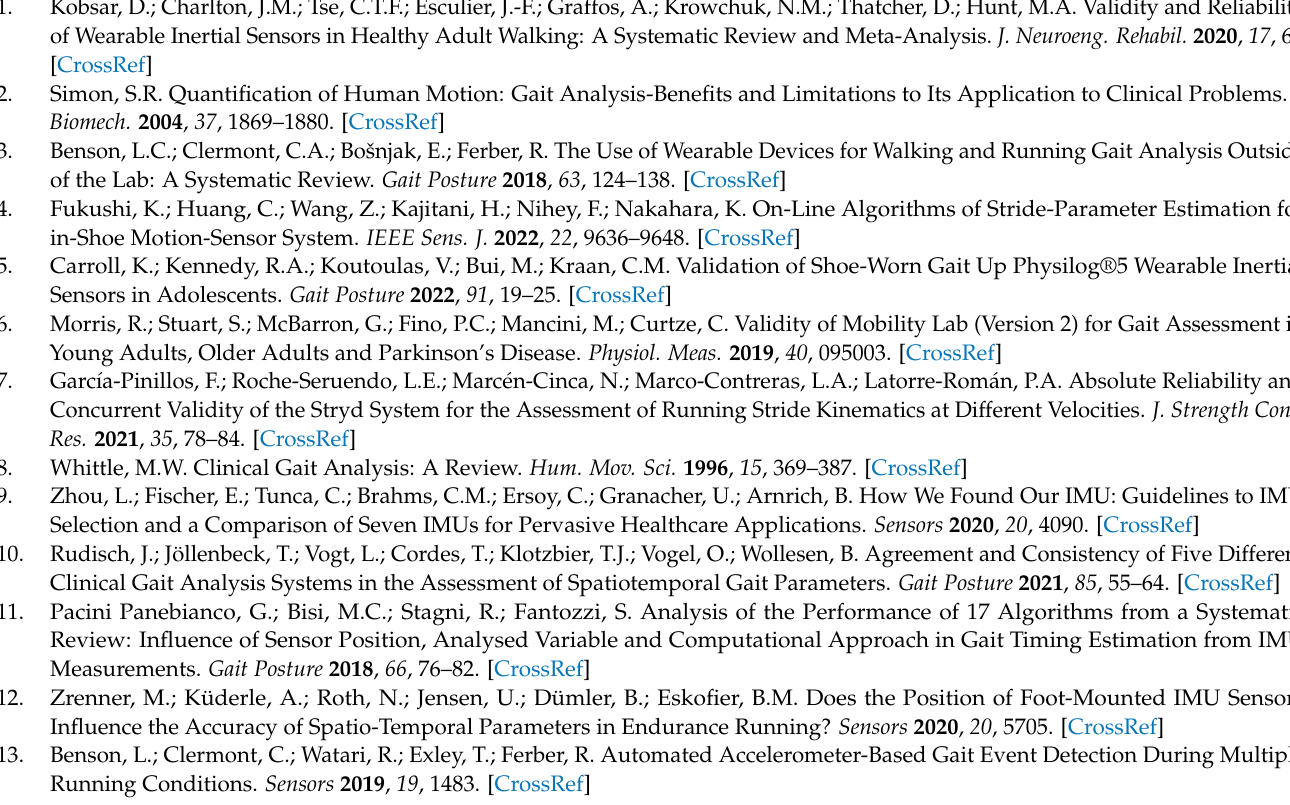
tion; Table S2: Number of gait cycles from motion sensor data for the analysis; Table S3: Gait-cycle detection ratio for the conditions; Table S4: Percentage of gait cycles including outliers for the condi- tions; Figure S1: Definition of target markers for detecting the initial foot contact timing; Figure S2: Scatter plots and regression lines of the stride length and speed from ORPHE ANALYTICS and the optical motion capture and the Bland–Altman plots of corrected data using regression